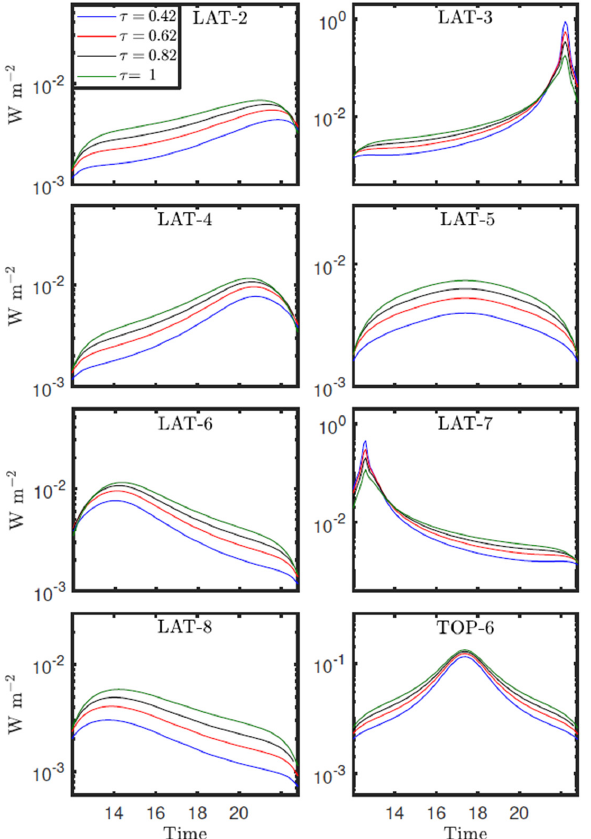
Figure 23. Simulated daytime RDS lateral and TOP-6 sensors output intensities for different dust opacities (or number densities). The rest of the dust parameters were set to r eff = 1.25 µm, v eff = 0.22, and n = 1.5 + 0.0004 i .